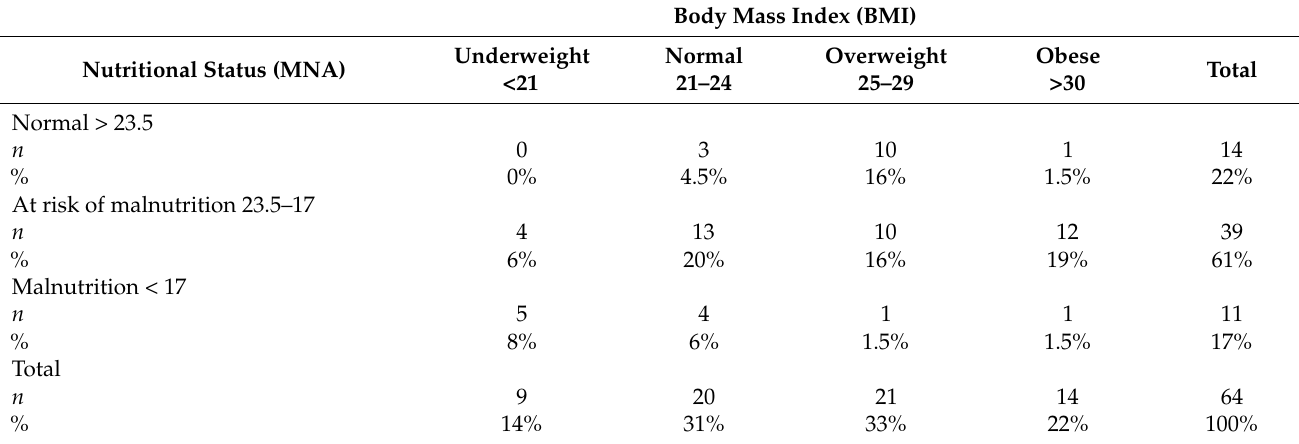
Table 4. The prevalence of nutritional risk (MNA) by weight status categories